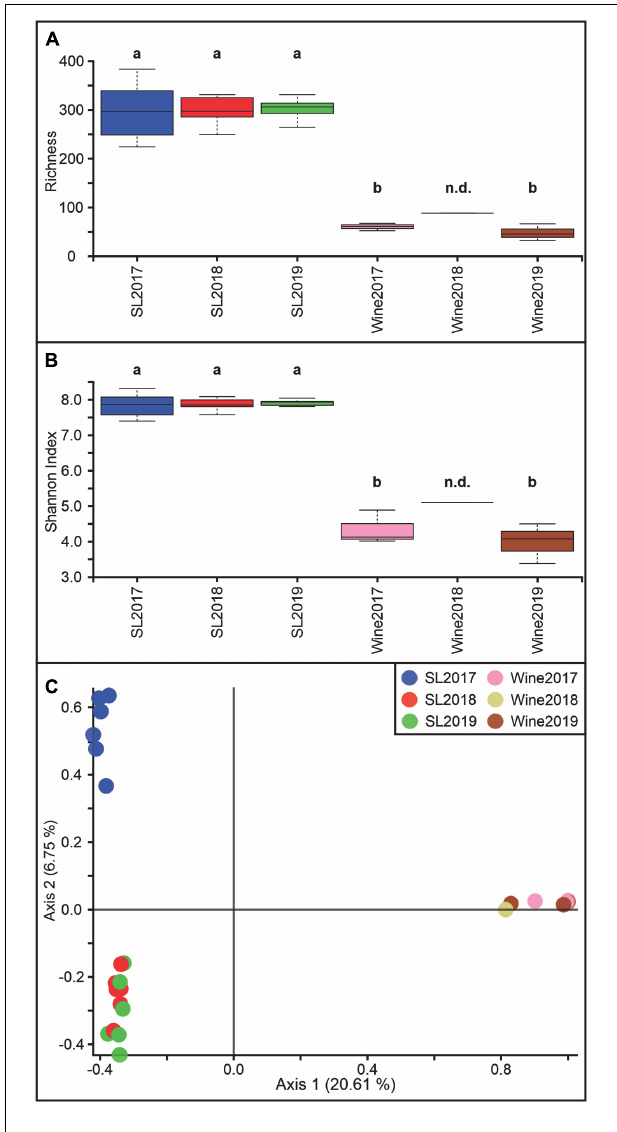
FIGURE 2 | Bacterial diversity estimation at the Saldungaray vineyard for the years 2017, 2018, and 2019. For the soil (SL) and wine samples, Alpha diversity was estimated based on richness (A) and the Shannon index (B) . Different letters indicate statistical differences ( p < 0.05). There was not enough data for the 2018 wine sample, therefore statistics remain non-determinate (n.d.). Principal coordinate analysis (PCoA) was performed to analyze the beta diversity at the Saldungaray vineyard based on Bray Curtis distances (C)